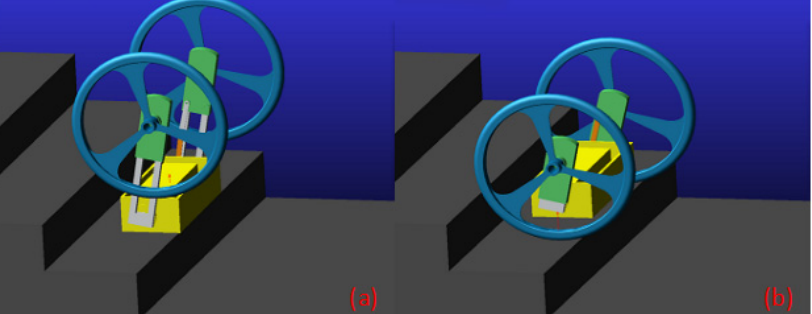
Figure 13. “Retraction and approaching” stair climbing gait simulation process diagram: ( a ) the two wheels are turned over to the steps of the frame; ( b ) the cantilevers drive the wheel back and the robot touches the next stair.